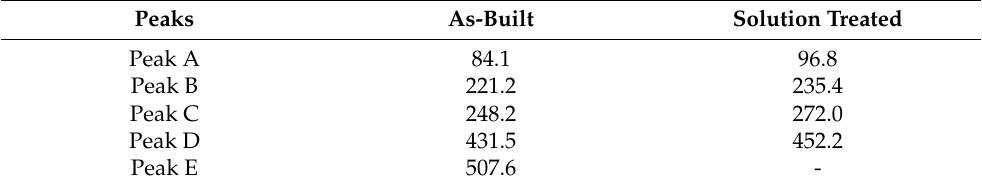
Table 4. Peak temperatures ( ◦ C) attained from the DSC curves of as-built and solution treated